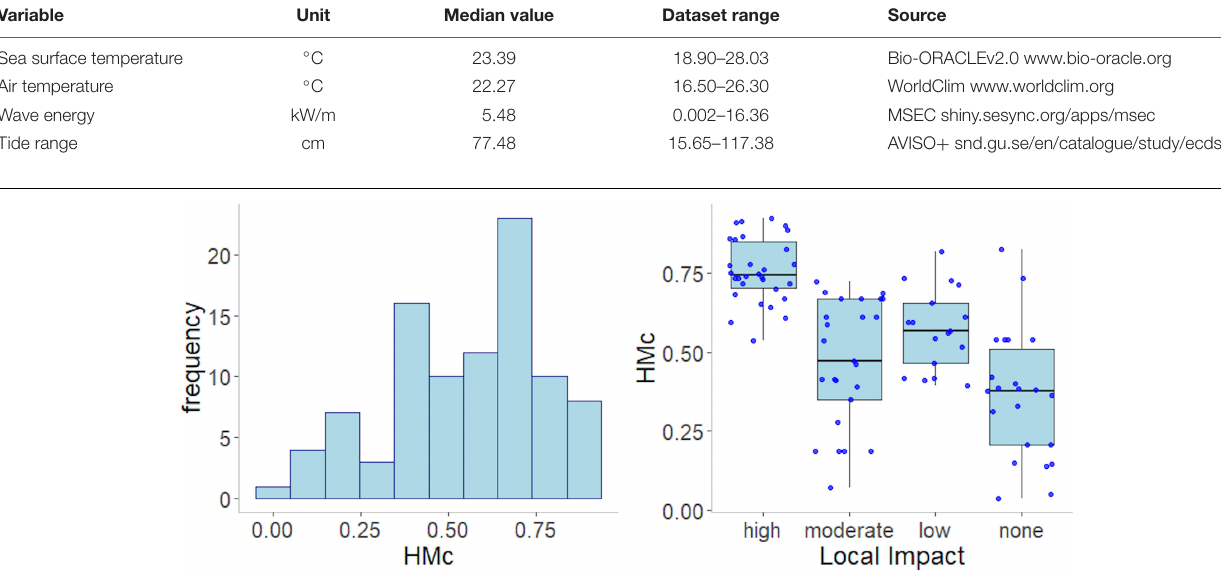
TABLE 1 | Summary statistics from the environmental variables of 94 beach sandy beach sectors of Western Atlantic.